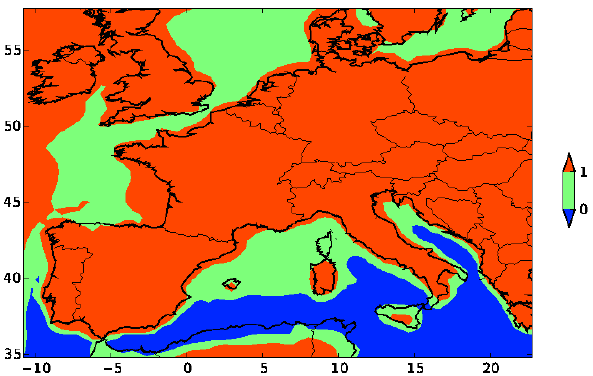
Fig. 7. Monthly-mean gas ratio (GR) in summer 2001 over Europe. GR < 0: acidic sulfate aerosol (blue), 0 < GR < 1: nitrate formation limited by ammonia (green), GR > 1: nitrate formation limited by HNO 3